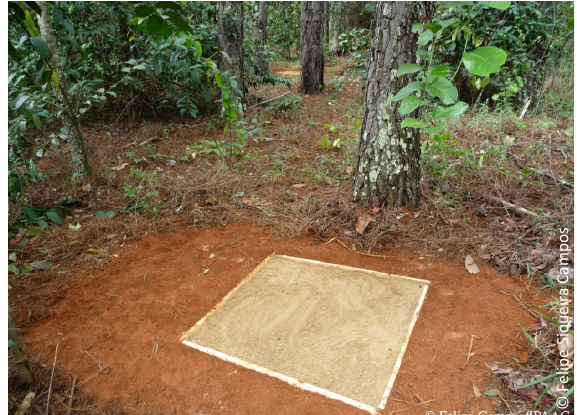
Image 1. Footprints trap (sand plots).